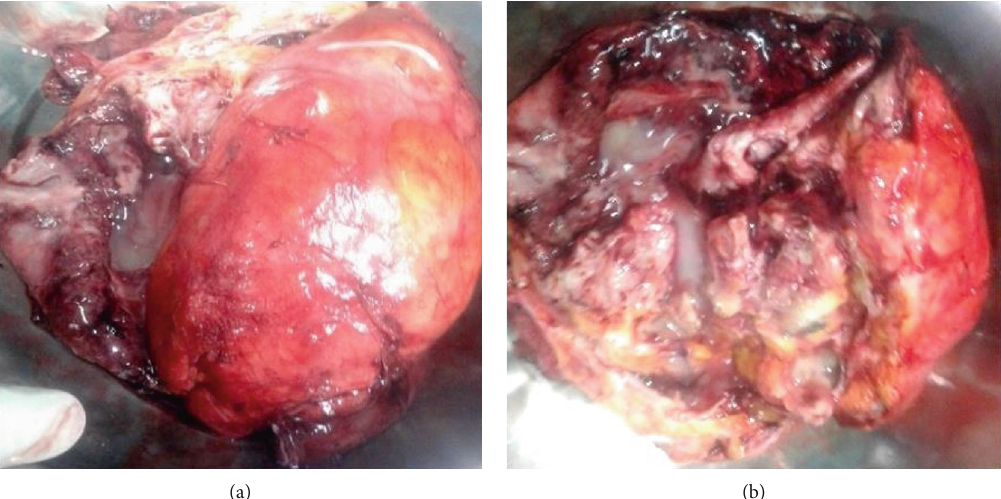
Figure 3: (a, b) Gross postoperative specimens showing heterogeneous soft tissue mass containing fatty areas and bony and cartilaginous tissues.